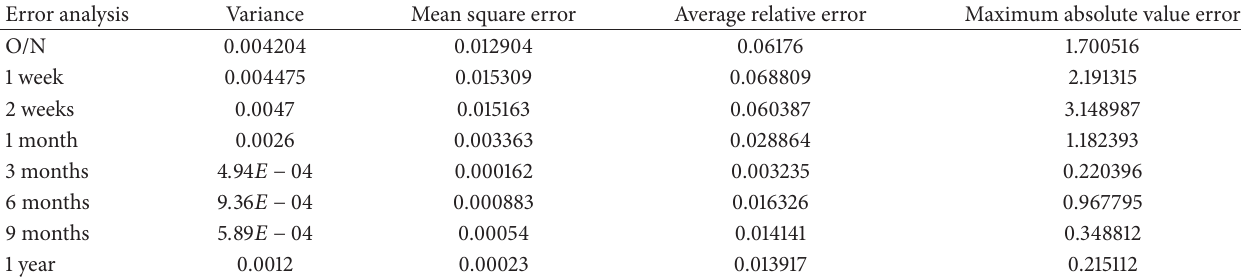
Table 4: The fitting errors of the SHIBOR two-factor Vasicek